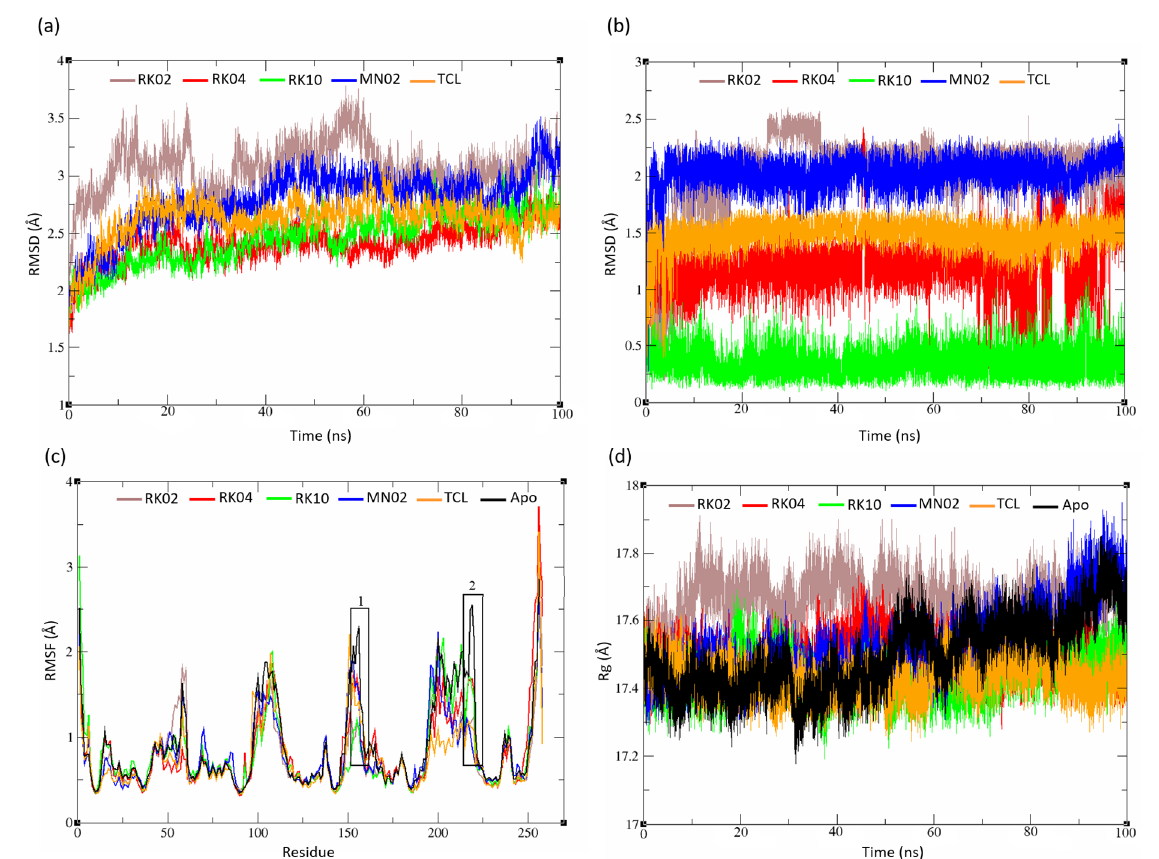
Figure 5. Unsubstituted Diphenylmethane set analysis. ( a ) Complex RMSD, ( b ) ligand RMSD, ( c ) backbone RMSF and ( d ) radius of gyration. The obtained data have shown that all complexes are stable throughout the 100 ns of MD simulation.